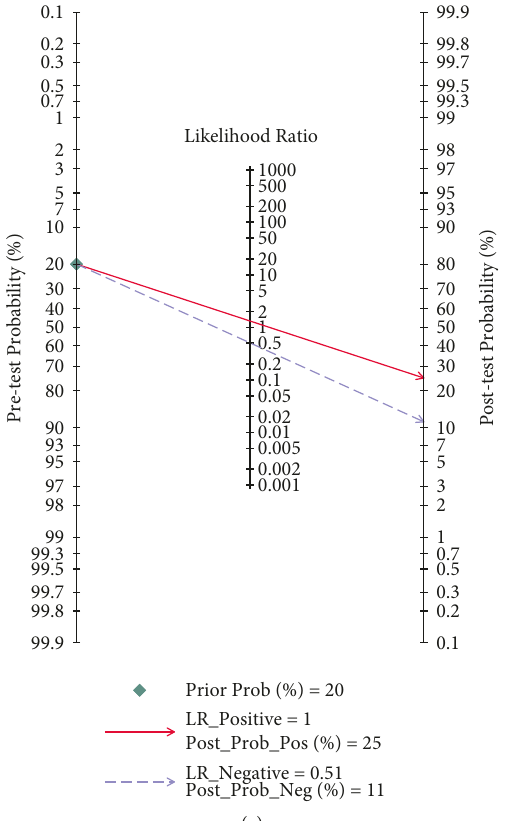
Figure 4: The forest plot of the (a) sensitivity and specificity of SIRS, (b) the summary receiver operating curve of SIRS, and (c) pre- and posttest probability of SIRS for patients in the ED. Table 2: Subgroup analysis of sensitivity and specificity for qSOFA and SIRS. Subgroup